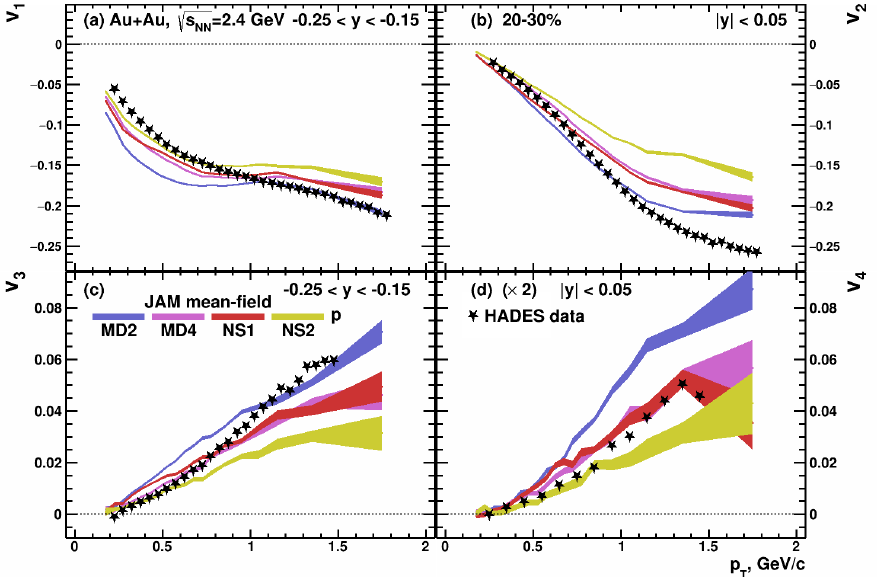
Figure 6. p T dependence of anisotropic flow coefficients v 1 , v 2 , v 3 and v 4 of protons ( a – d ) in the √ s NN = 2.4 GeV. The black closed symbols denote the published 20–30% central Au + Au collisions at data from the HADES experiment [17]. The blue (MD2), purple (MD4), red (NS1) and yellow (NS2) bands represent the results from the mean-field mode of the JAM model with different EOS, as indicated. The uncertainties of the simulated model data are